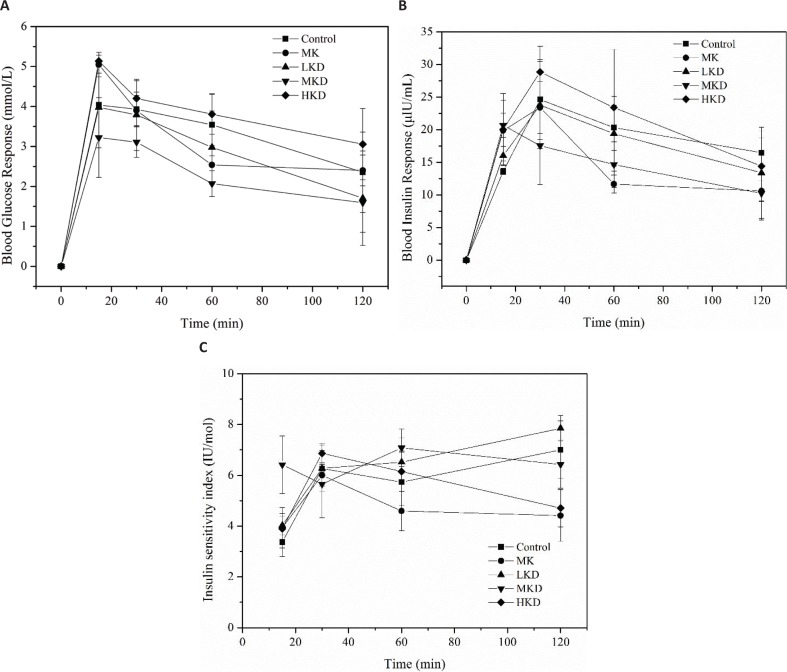
Effect of different noodles-based KGM on postprandial blood glucose: (a) changes in blood glucose response, (b) blood insulin response, and (c) insulin sensitivity of mice after intragastric administration. The animal was raised under normal experimental conditions, and it was free to feed and drink for 1 week. Data are representative of data obtained from four animals randomly selected from each group. LKD: precooked noodles based 2 wt% KGM, MKD: precooked noodles based 4 wt% KGM, HKD: precooked noodles based 8 wt% KGM, and MK: 4 wt% KGM mixed directly with precooked noodles. The error bars indicate the standard deviations of duplicate measurements.